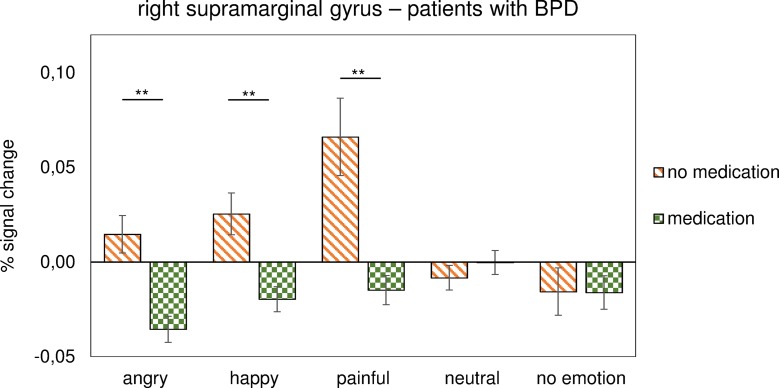
Activation during emotional face processing in percent signal change for the right supramarginal gyrus in patients with BPD. The diagram compares patients under medication with unmedicated patients. Error bars represent SEM and *p < 0.05, **p < 0.010, ***p < 0.001.